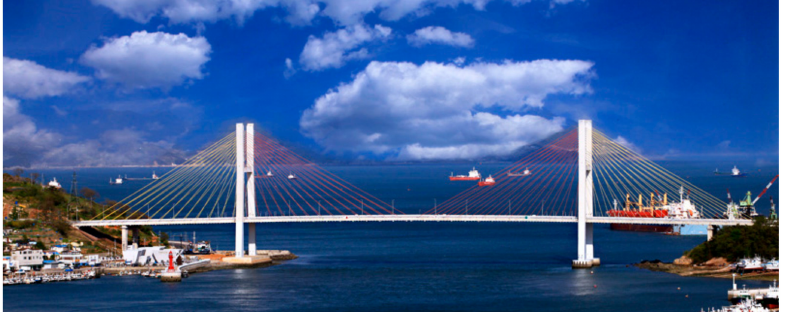
Figure 5. Overview of the reference bridge.